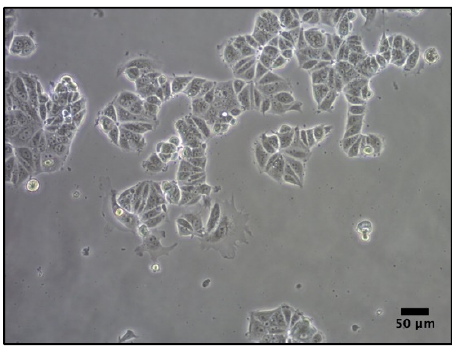
Figure 10. MCF7 cell line in 2D adherent culture.